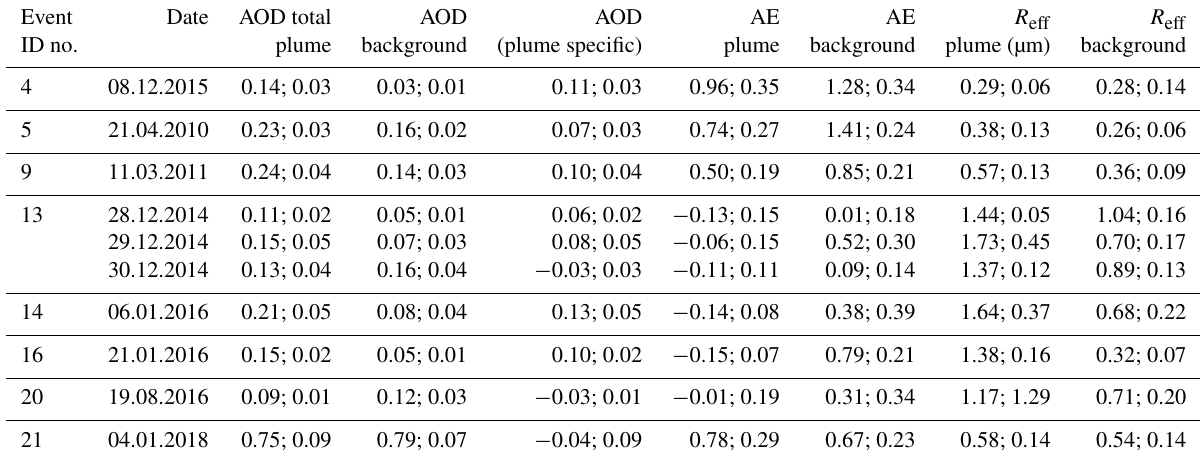
Table 4. Mean and standard deviation values of aerosol properties (AOD, AE, R eff ) based on MODIS Aqua successful retrievals. Event plume background (plume specific) plume background plume (µm)